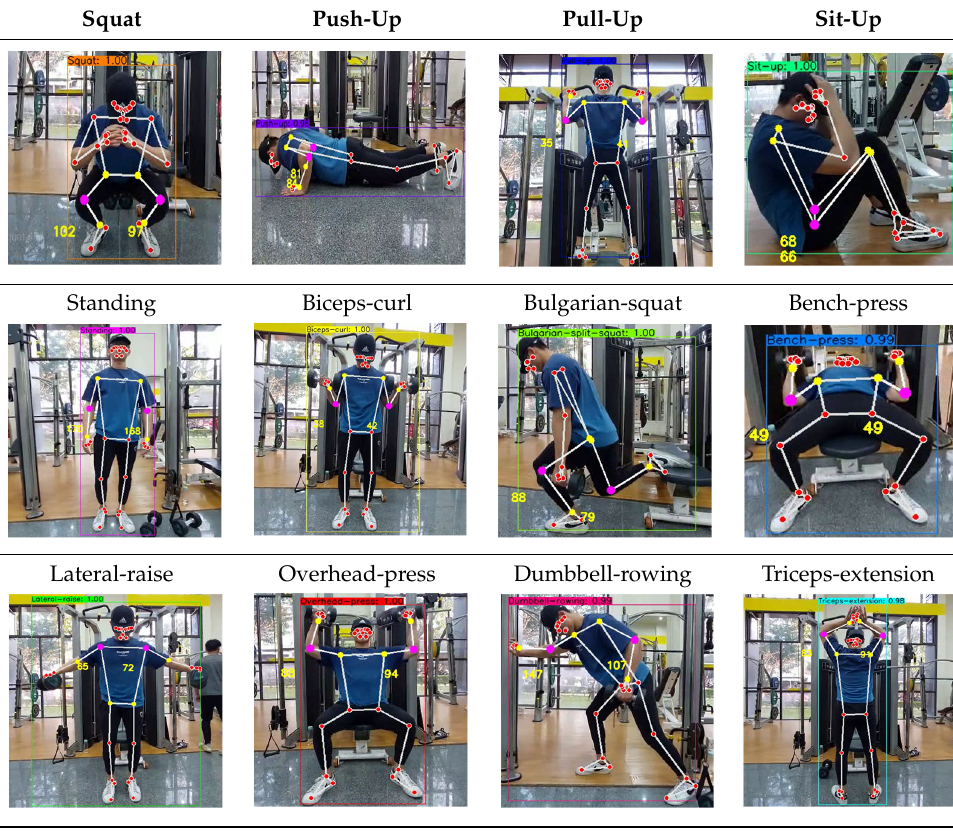
Table 6. Result of Mediapipe and Yolov4 detecting fitness.